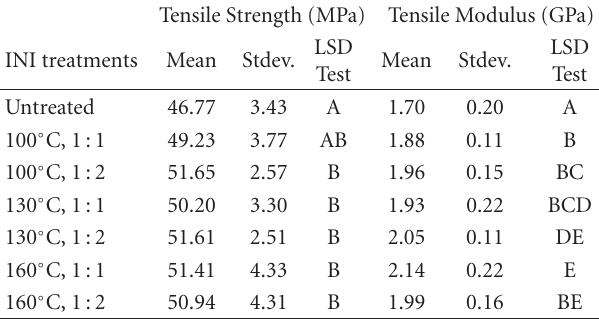
Figure 5: Stress-strain curves of the INI-treated fiber/PP compos- ites. The labels mean the INI treatments conditions for the kenaf fibers. Untreated fiber is the control fiber that has been retted at 160 ◦ C but not treated with INI processes. Table 4: Tensile strength and tensile modulus of INI treated fiber/PP composites.